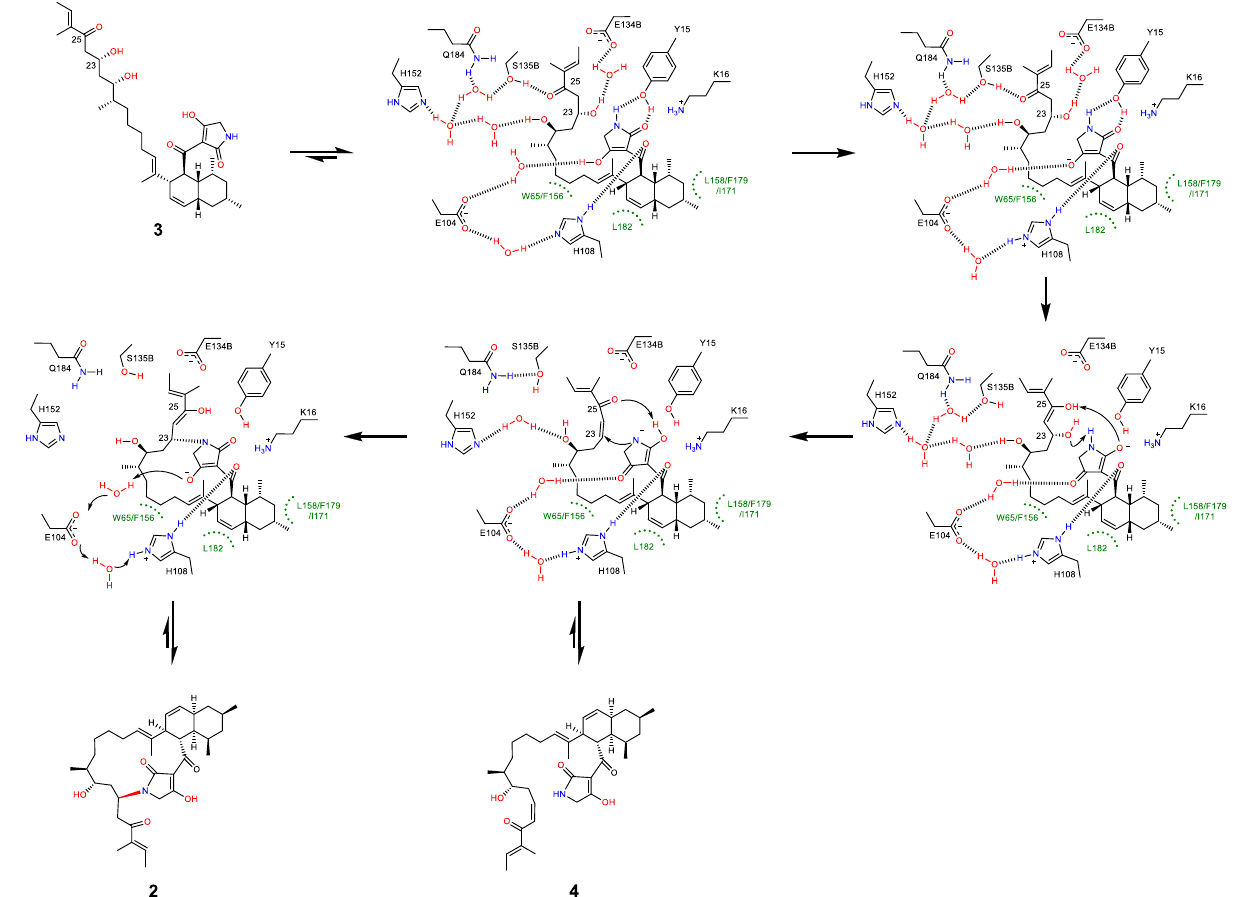
Fig. 5 | Proposed reaction mechanism for AvmM. The bolddashedline indicates the putative hydrogenbonds. E104 and H108are linked by three watermoleculesand only one is shown for